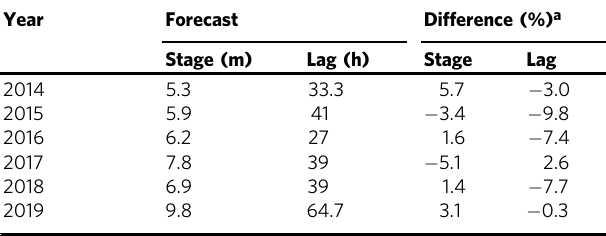
a The reference values for the comparison are the measured values of the stages and time of crest